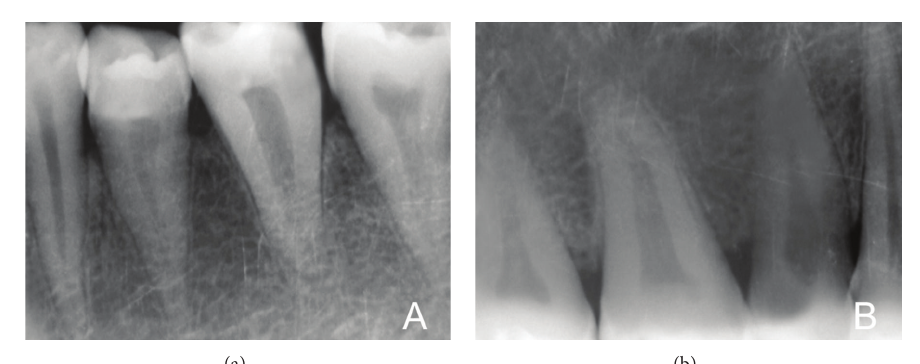
Figure 2: (a) Radiograph shows all the mandibular posterior teeth: contralateral side. (b) Radiograph shows all the right maxillary posterior teeth with single